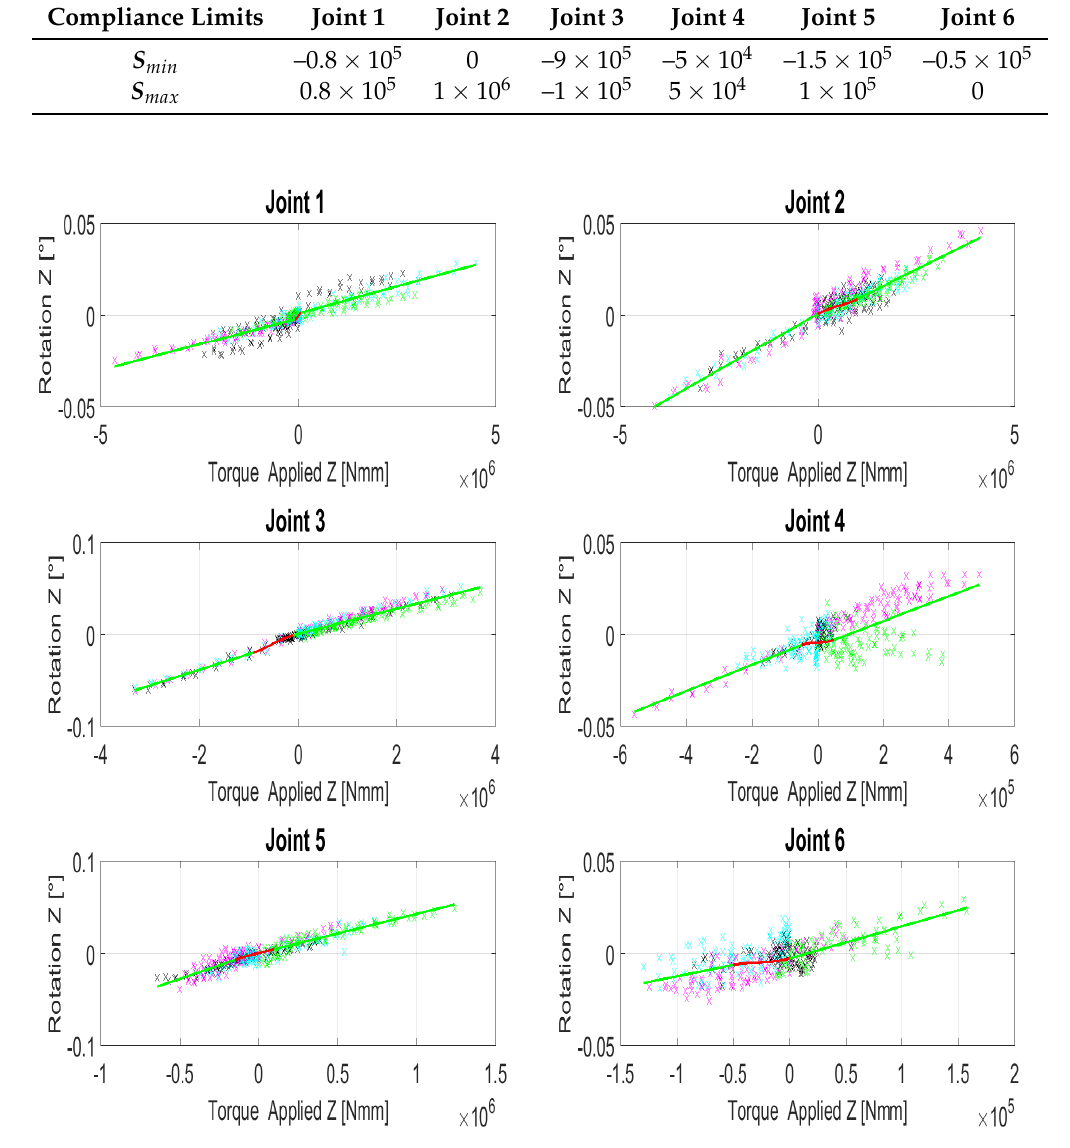
Table 2. Parameters for the linear functions of the compliance models for the robot Kuka KR270.